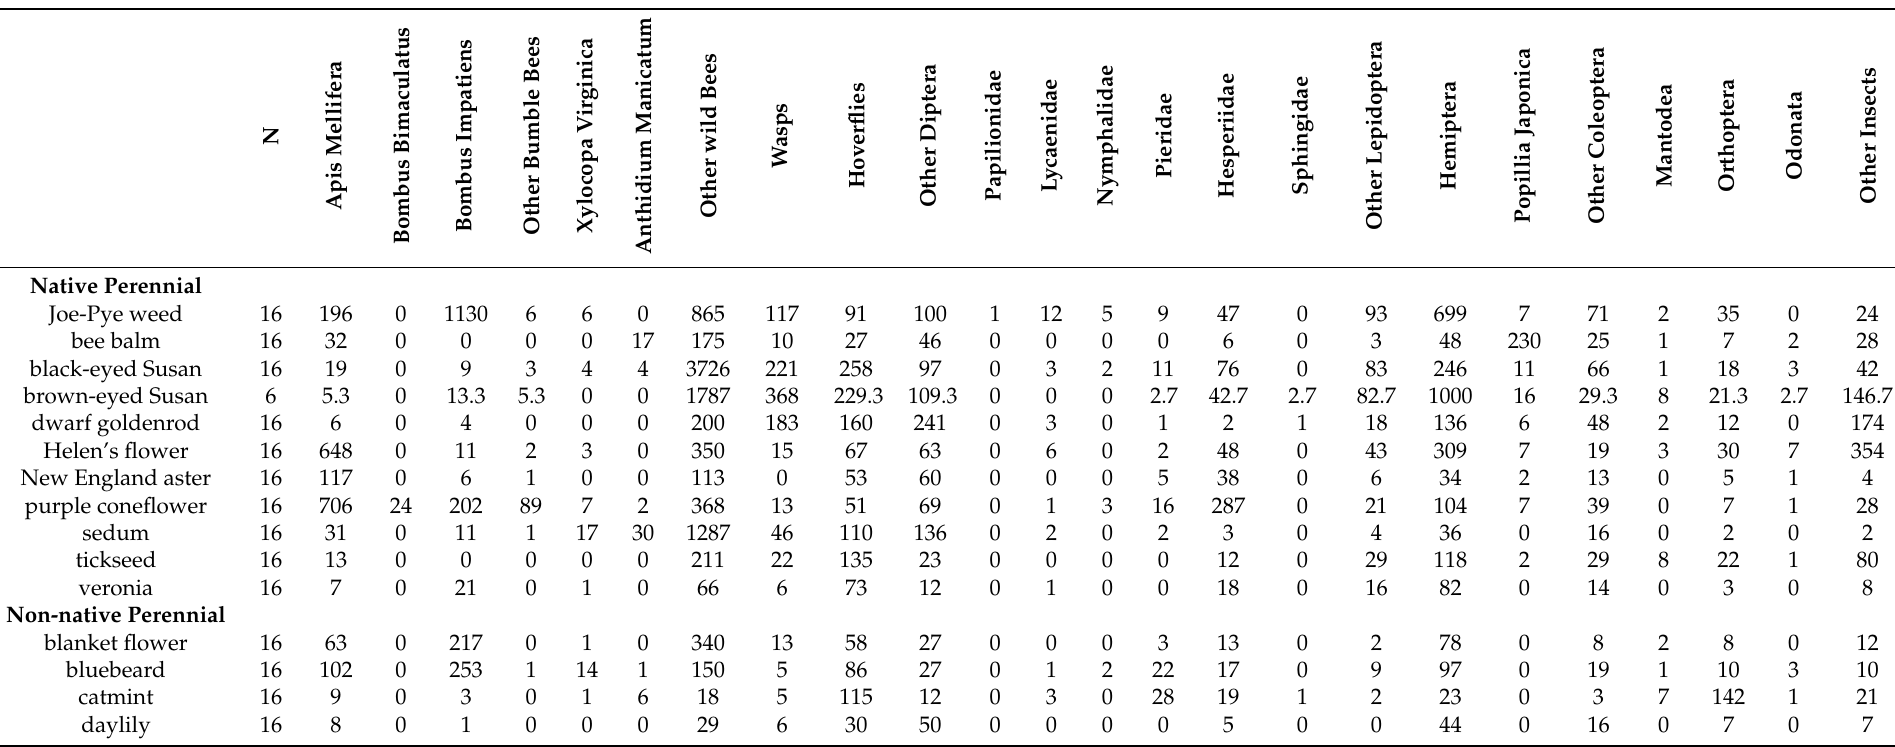
Table 1. Weighted counts of insects, grouped by the identification categories, per ornamental plant, and summed for all plots at both sites across both years. Plant species are grouped by whether they were native perennial, non-native perennial, or non-native annuals. N refers to the number of successful plots for that plant, where n = 16 indicates a plant that was present for both years and successfully grew in all four replicates at both sites. A total of 21 of our 25 plants fell into this category. Insect identification categories are ordered, from left to right, so that better resolved taxonomic categories to species or families come before the “Other” identifications for that